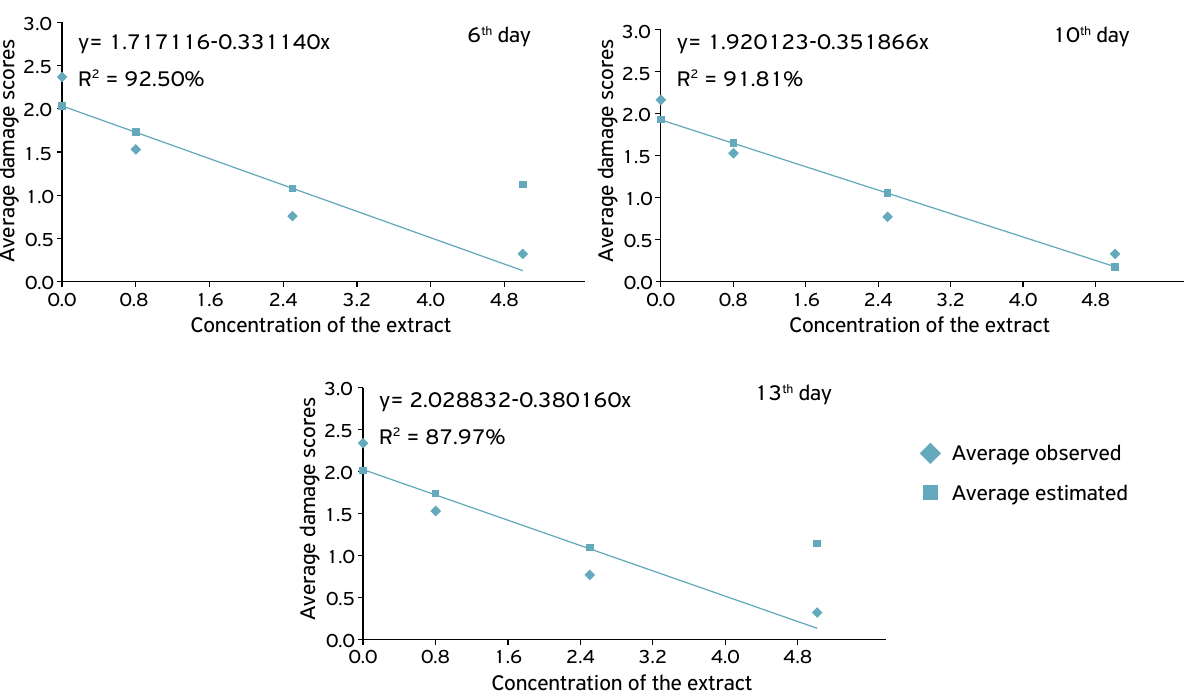
Figure 2. Average damage scores attributed to Spodoptera frugiperda feeding on corn plants sprayed with different concentrations of an aqueous extract of pequi ( Caryocar brasiliense ) fruit peels, separated by number of days after the first